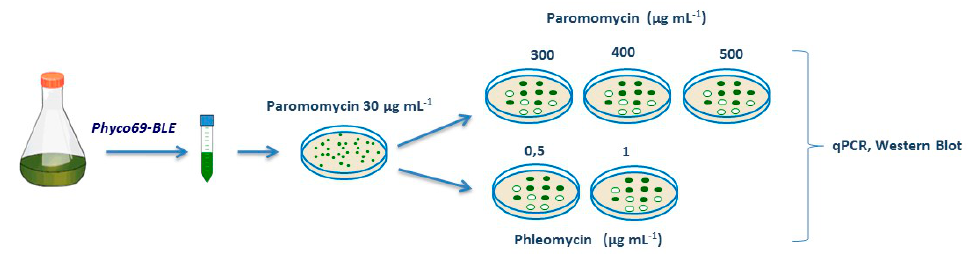
Figure 2. Schematic diagram of the selective strategy used to choose Chlamydomonas transformants with high levels of expression of genes APHVIII and ShBLE .